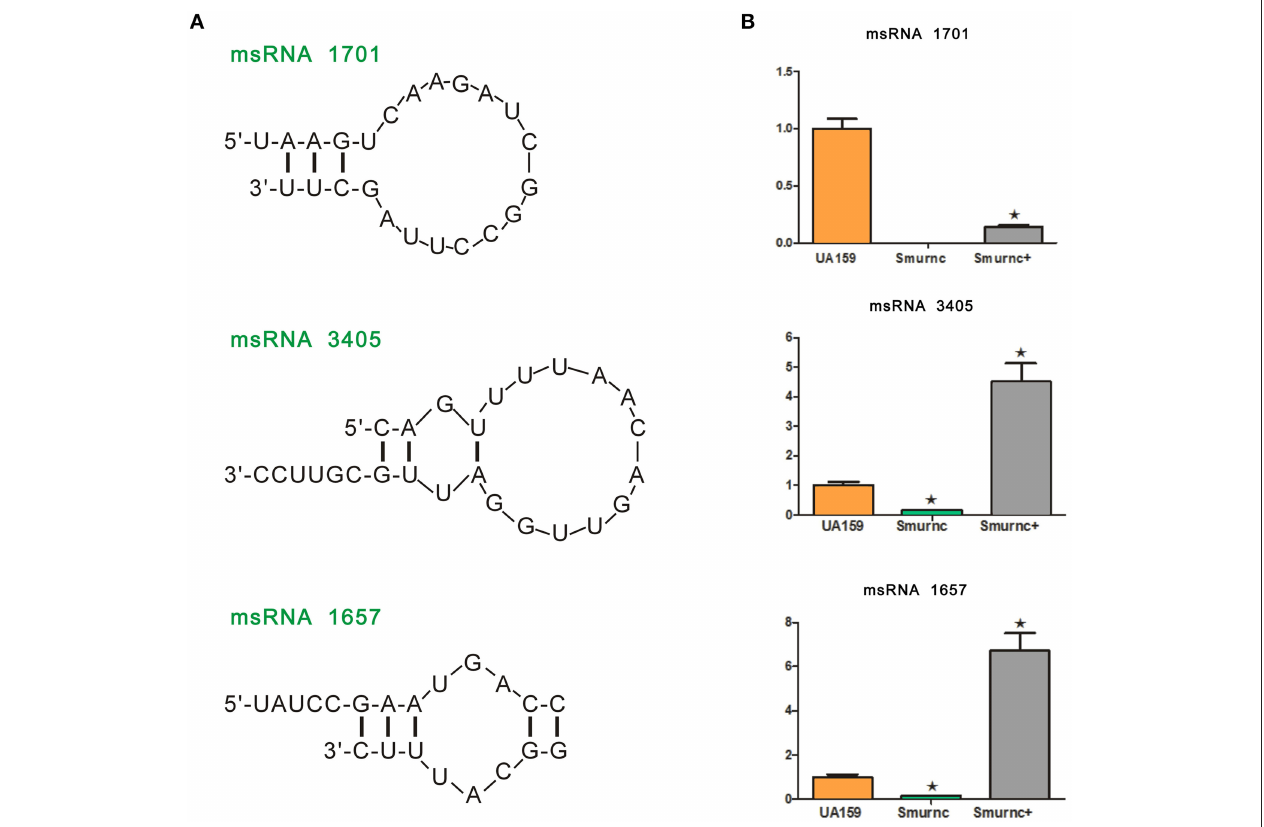
FIGURE 5 | Presentation and validation of the deep sequencing data by secondary structure prediction and expression analyses. (A) Predicted secondary RNA structures formed by three validated msRNAs, registered by deep sequencing. (B) Comparison of expression levels of three validated msRNAs in UA159 and rnc mutations by stem loop RT-PCR. The fold changes were shown after standardization relative to 16s RNA using UA159 as a reference. The data were represented as the means and standard deviation values. Asterisks indicate significant differences ( P < 0.05 ); ns, no significant